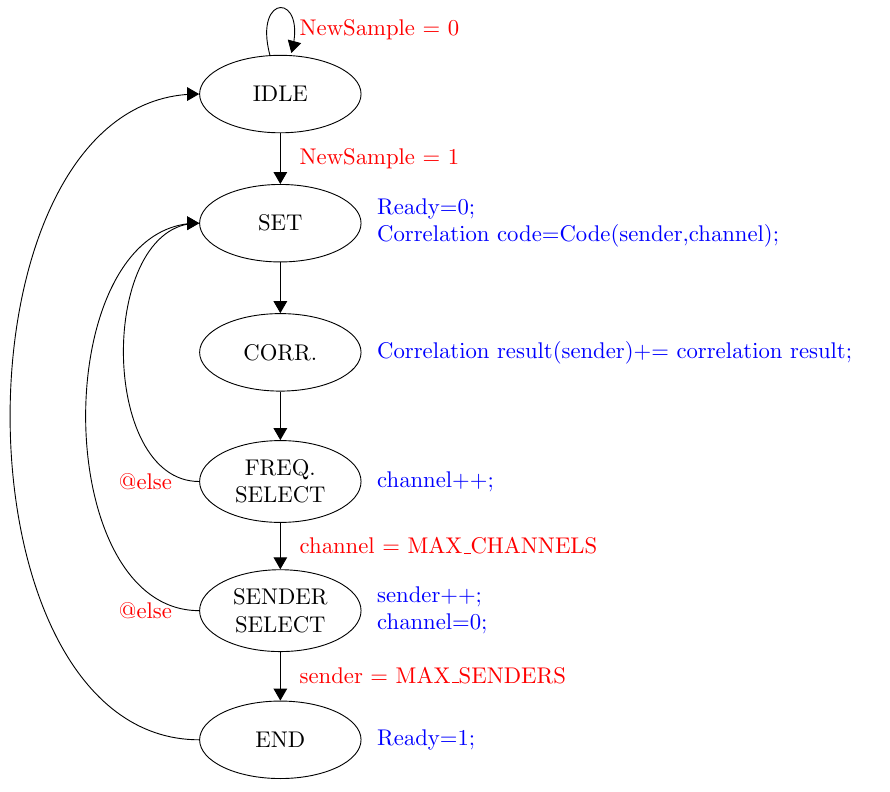
Figure 8. State machine of the correlation controller. Blue labels indicate the state operations, while the red labels refer to conditions between state transitions.